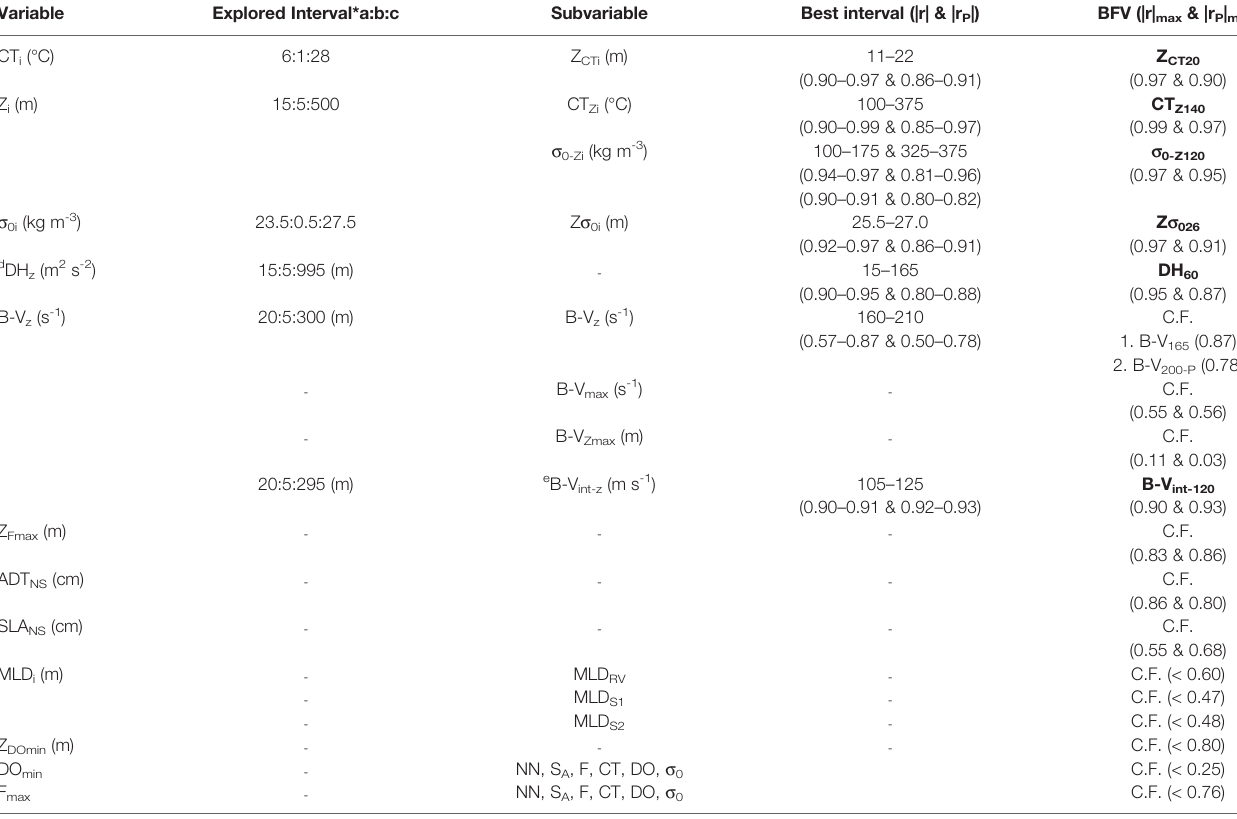
TABLE 1 | Variables considered in the classi fi cation of stations into cyclonic (CE), no eddy (NE), and anticyclonic (AE) groups. .